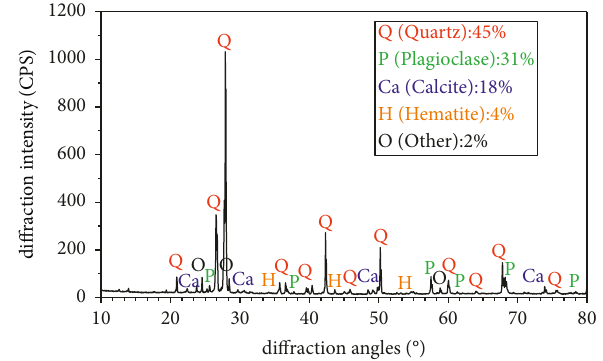
Figure 2: X-ray diffraction pattern of granite.